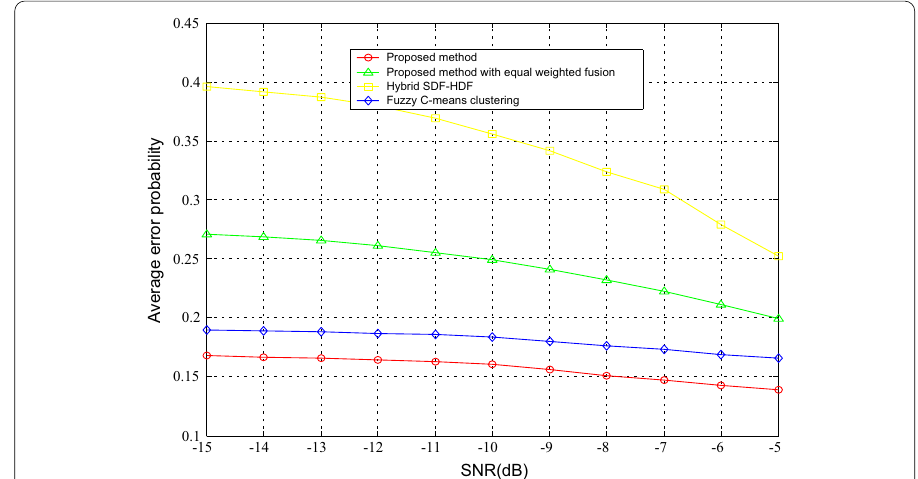
Fig. 3 Comparison of average error probability under different SNR